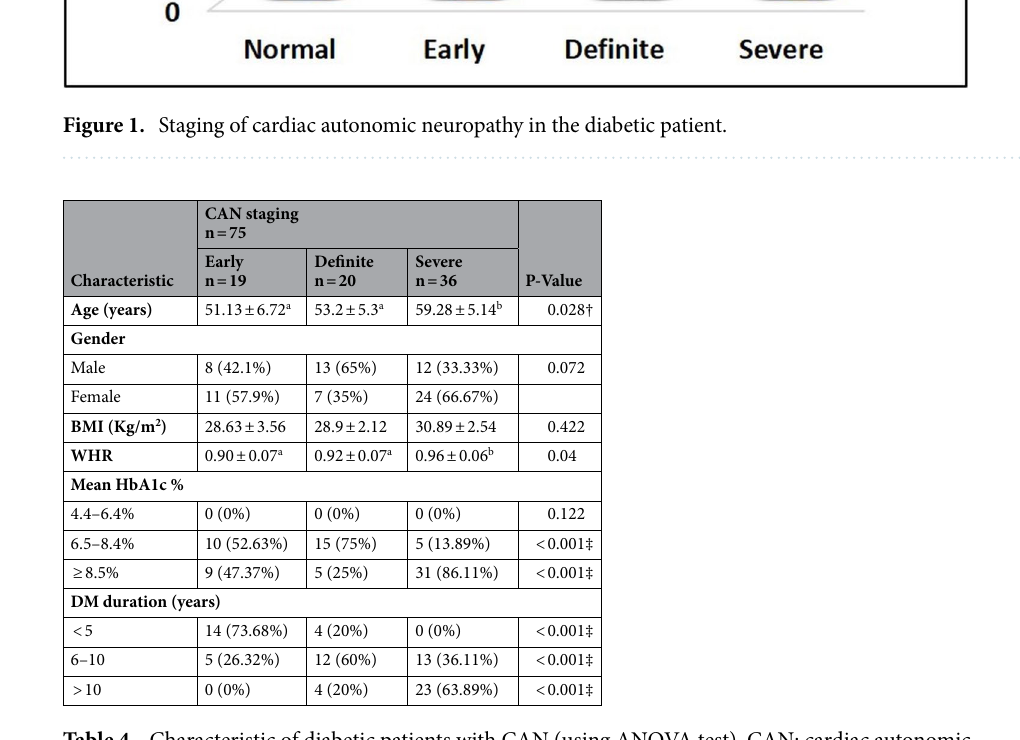
Table 4. Characteristic of diabetic patients with CAN (using ANOVA test). CAN: cardiac autonomic neuropathy; BMI: body mass index; WHR: waist-hip ratio; DML diabetes mellitus. † t-test, ‡ chi-square. Different small letters indicate significant